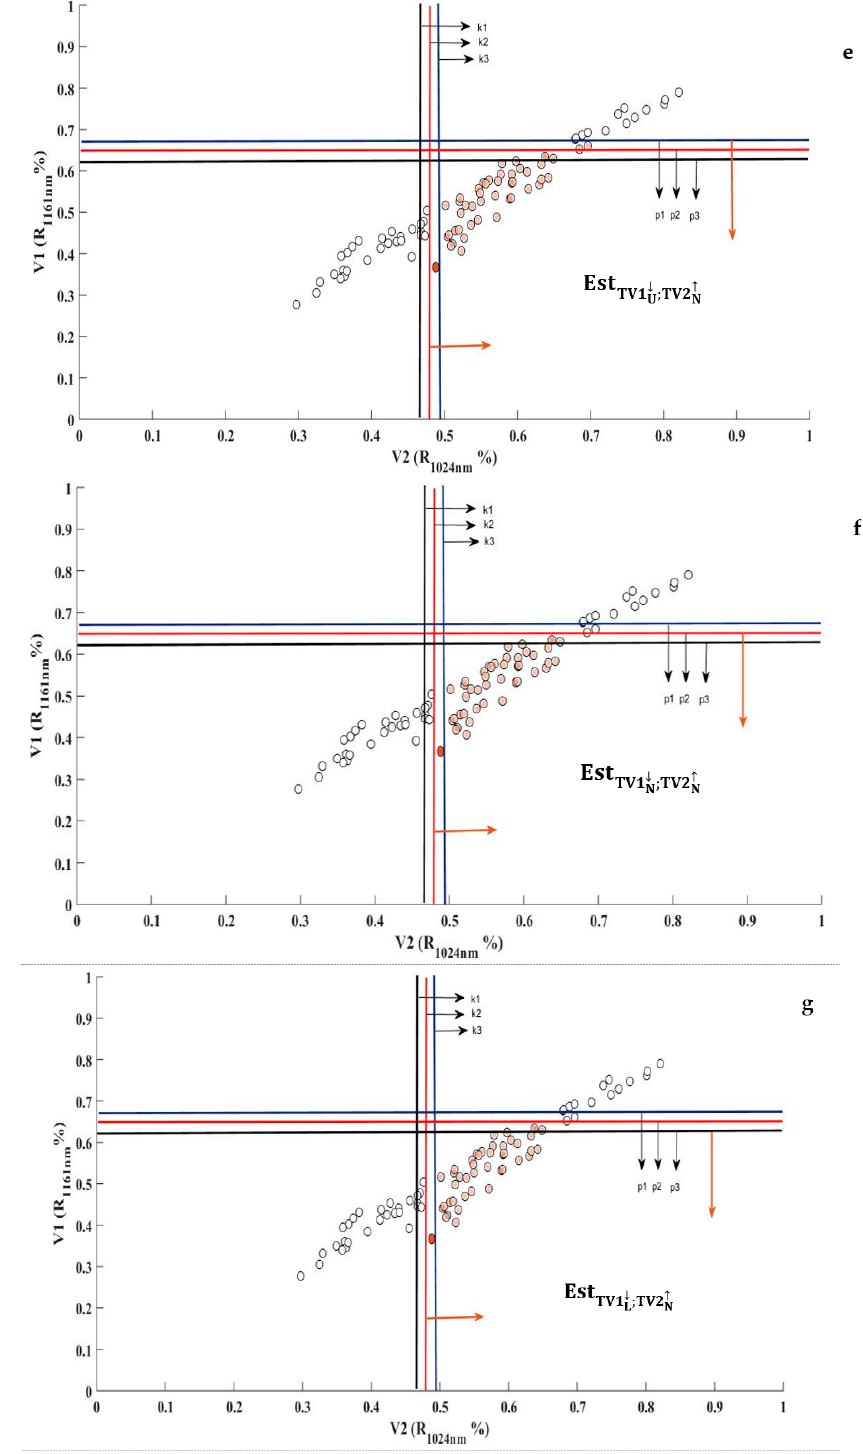
Figure A1. Scheme of training subgroup selection in one of the moderate snow class cases (brown points).